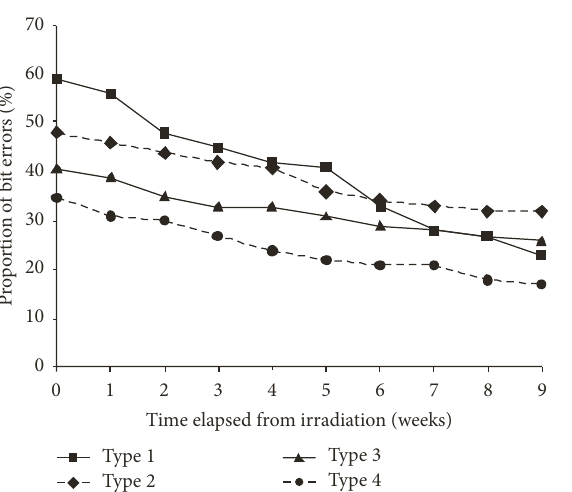
Figure 4: Recovery of the four tested types of flash memory at room temperature for nine weeks after exposure to a maximum dose of 12kGy.